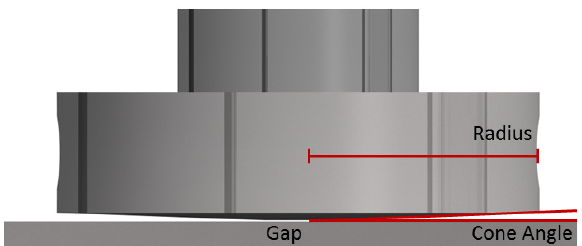
Figure 2. Implemented cone-plate geometry.